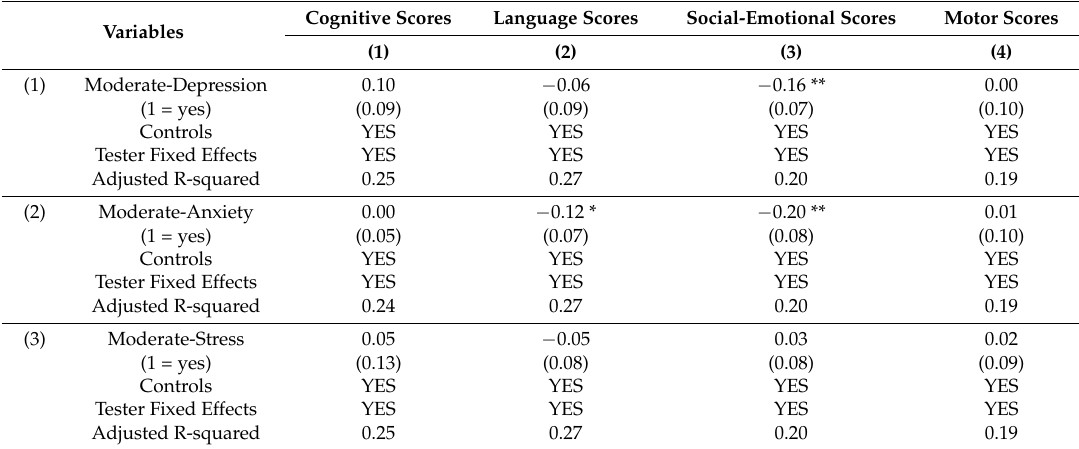
Table 6. Correlations between caregiver’s mental health and child development outcomes using ordinary least squares, n =